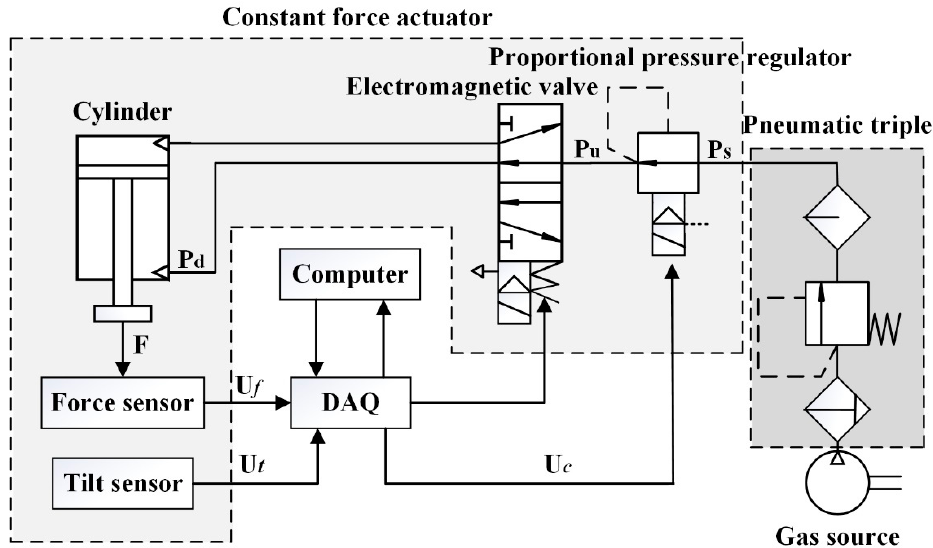
Figure 2. Pneumatic system control diagram.